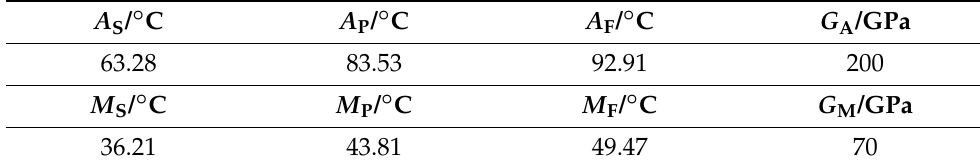
Table 3. Material parameters of SMA (Ni 51 Ti 49 (at.%))